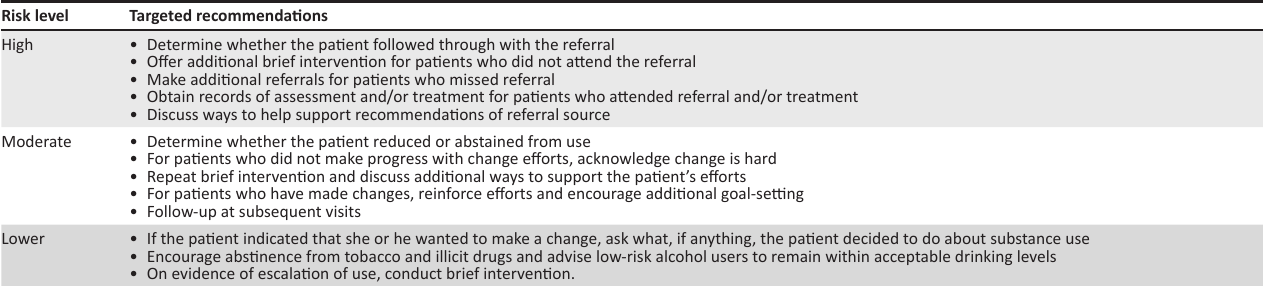
TABLE 3-A2: Follow-up or subsequent encounters.